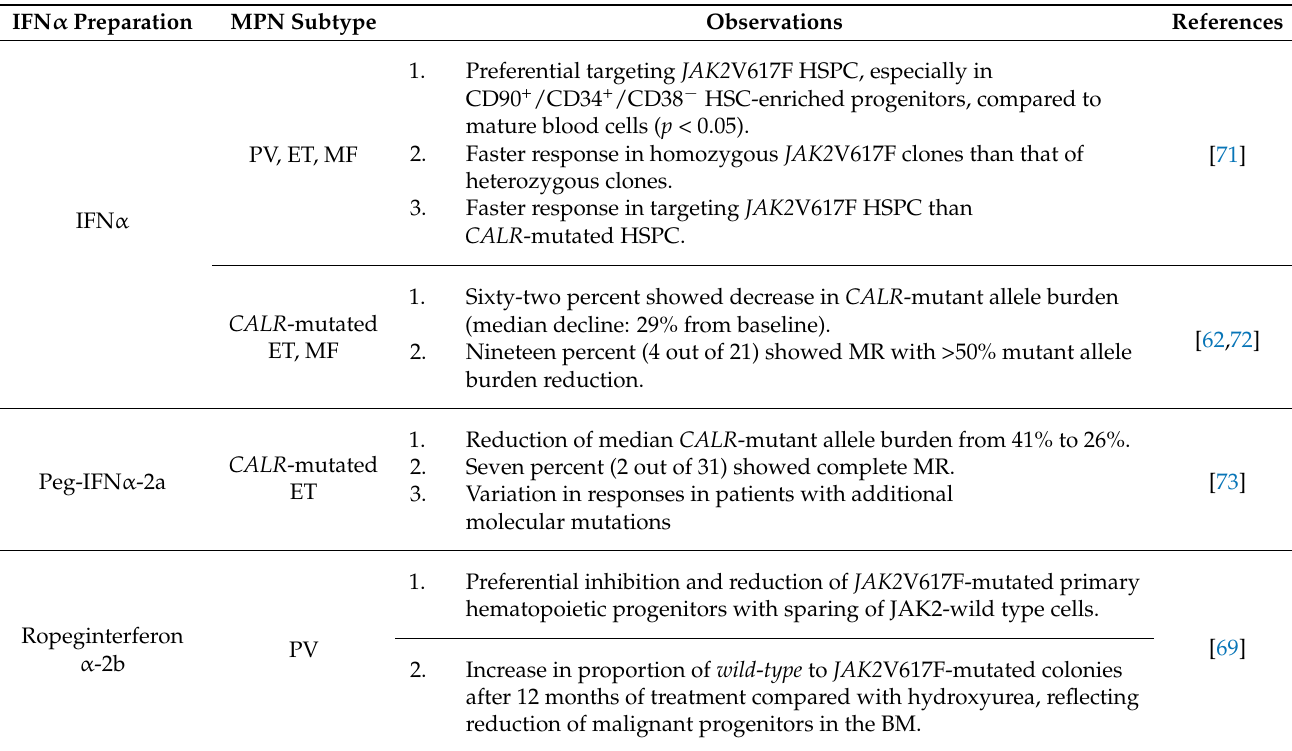
Table 2. Targeting of JAK2 V617F and CALR -mutated MPN by IFN α preparations.